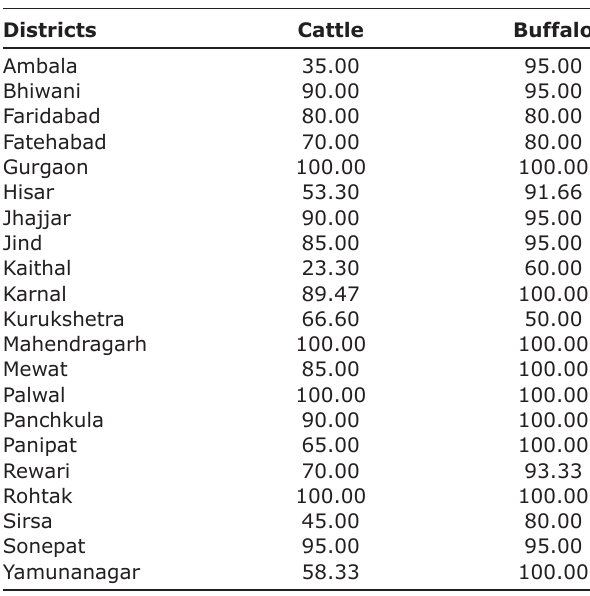
Table-5: District-wise seroprevalence of BTV in cattle and buffaloes of Haryana state.